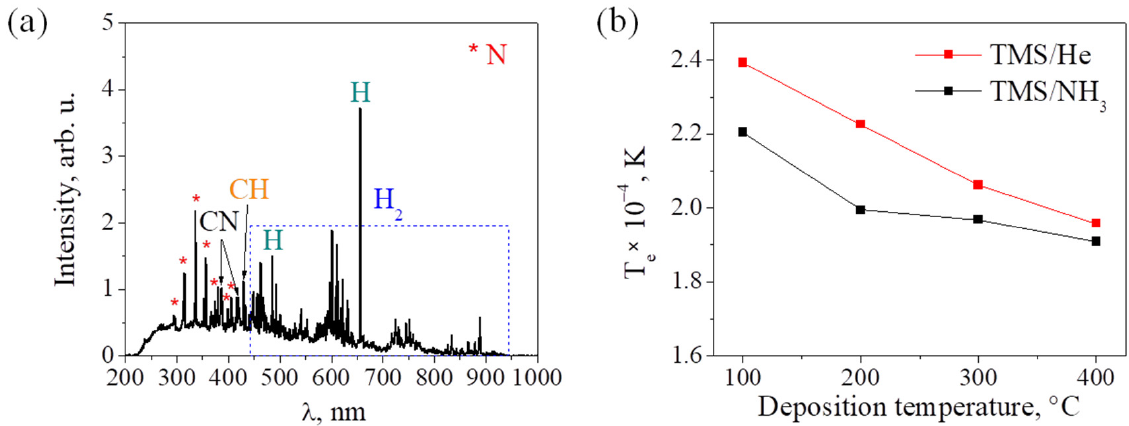
Figure 1. Emission spectrum of TMS plasma. N 2 bands were marked by asterisks ( a ); electron excitation temperature in TMS/He and TMS/NH 3 plasmas vs. deposition temperature ( b ).